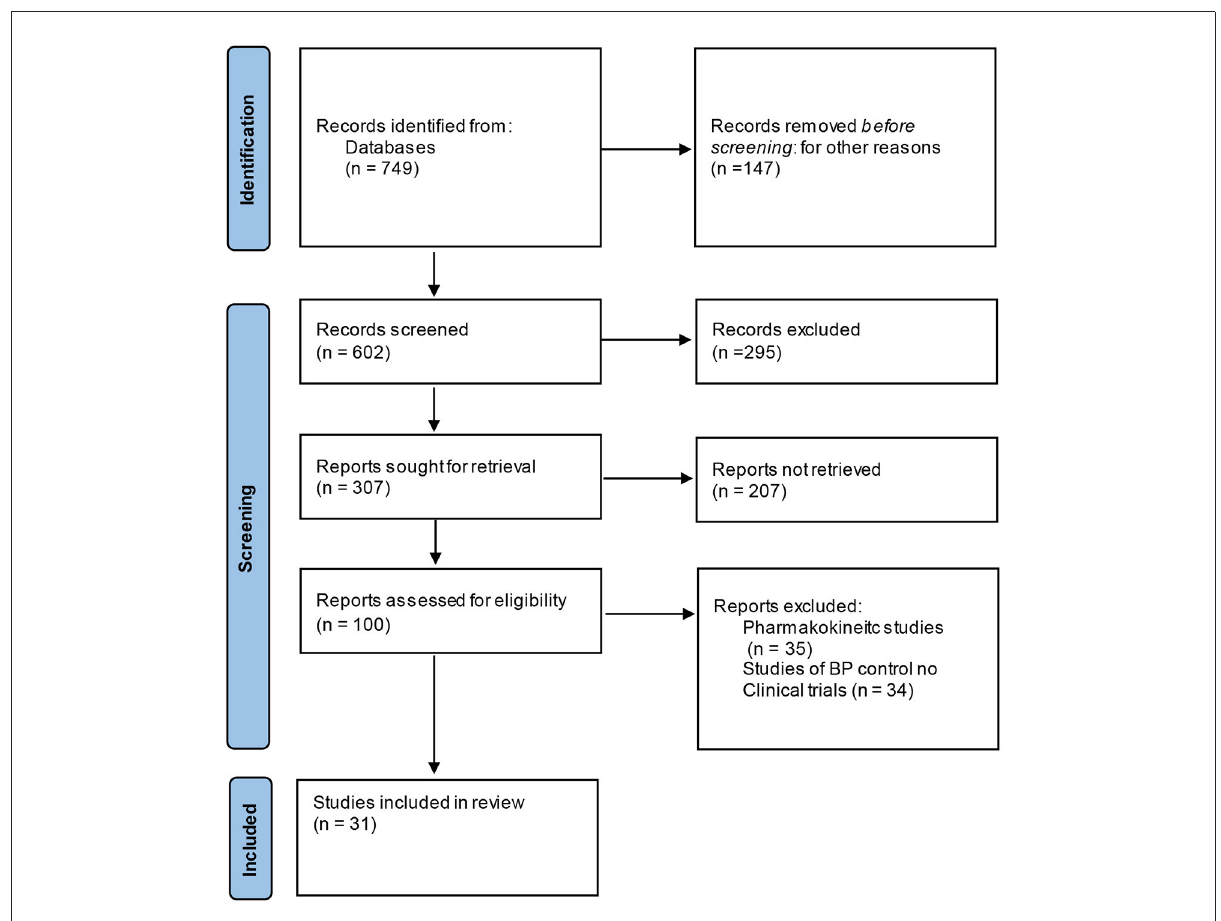
FIGURE1 Flow-chart of the studies